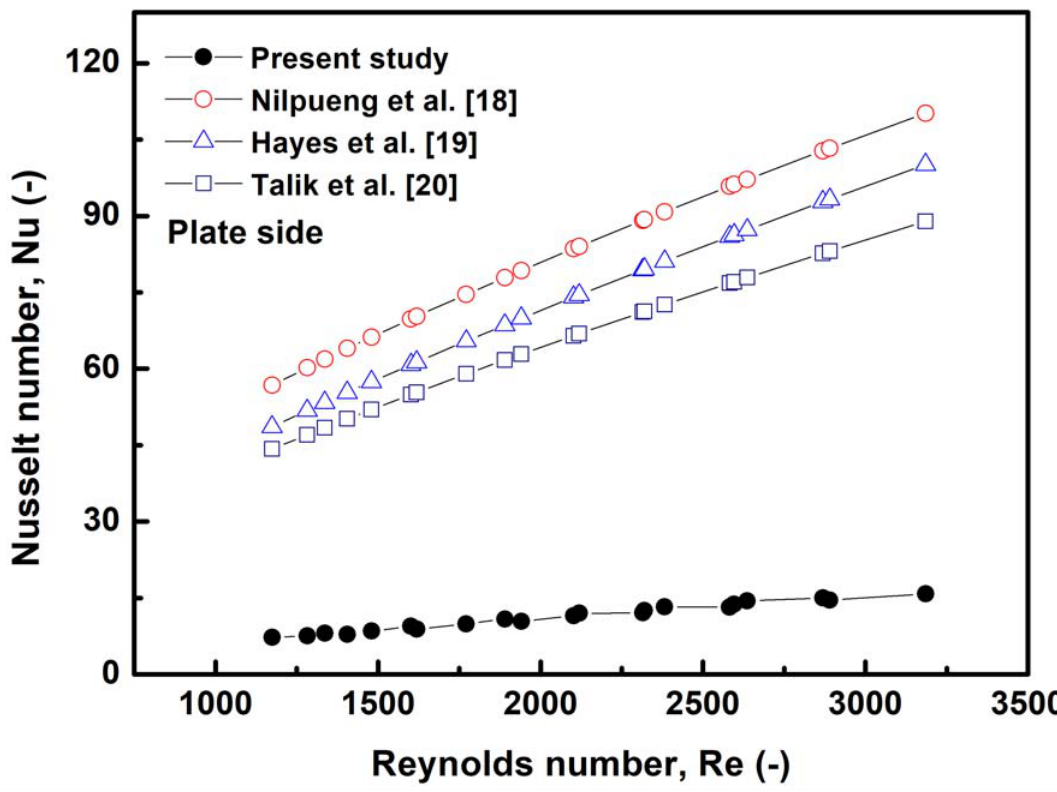
Figure 7. Comparison of the predicted Nu on the plate side using the present correlation with those using the existing correlations with respect to the Re.